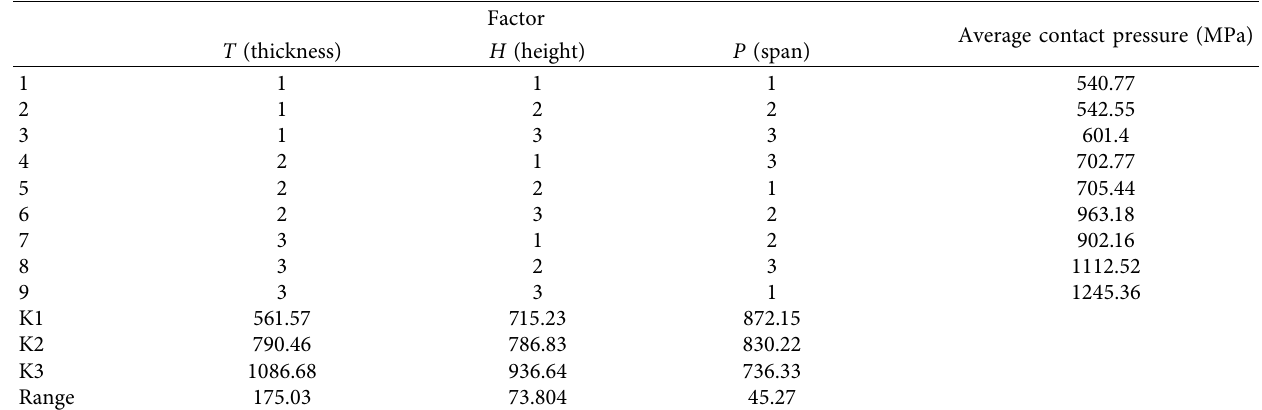
Table 5: Range analysis.